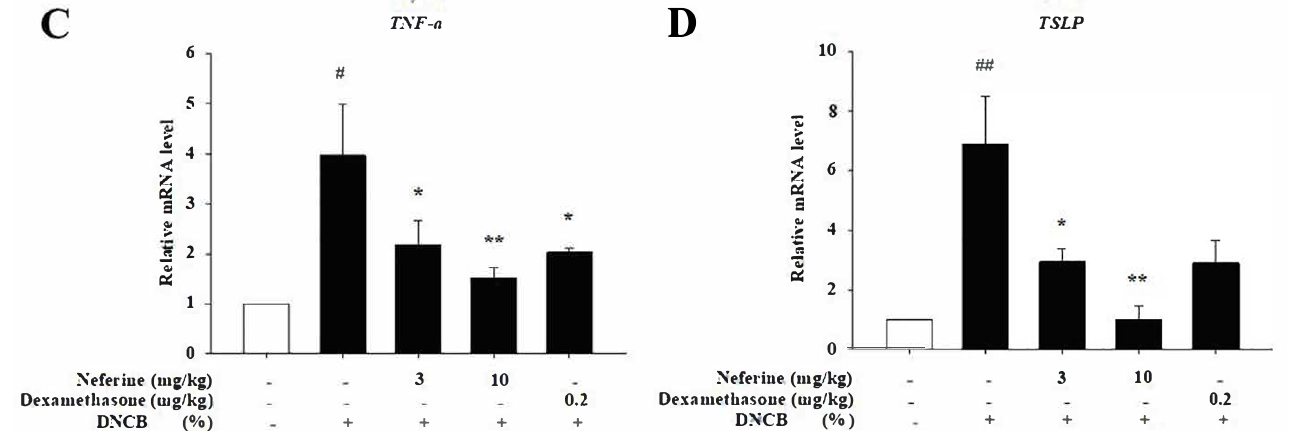
Figure 10. Effect of neferine on cytokine mRNA expression in BALB/c mice with an atopic-dermatitis-like phenotype. Total RNA was isolated and an mRNA analysis was performed via real-time RT-PCR. ( A ) IL-1 β , ( B ) IL-6, ( C ) TNF- α , and ( D ) TSLP. Values represent the mean ± SEM from at least six independent experiments. # p < 0.05; ## p < 0.01 compared with the no-treatment condition; * p < 0.05 and ** p < 0.01 compared with the DNCB-induced AD